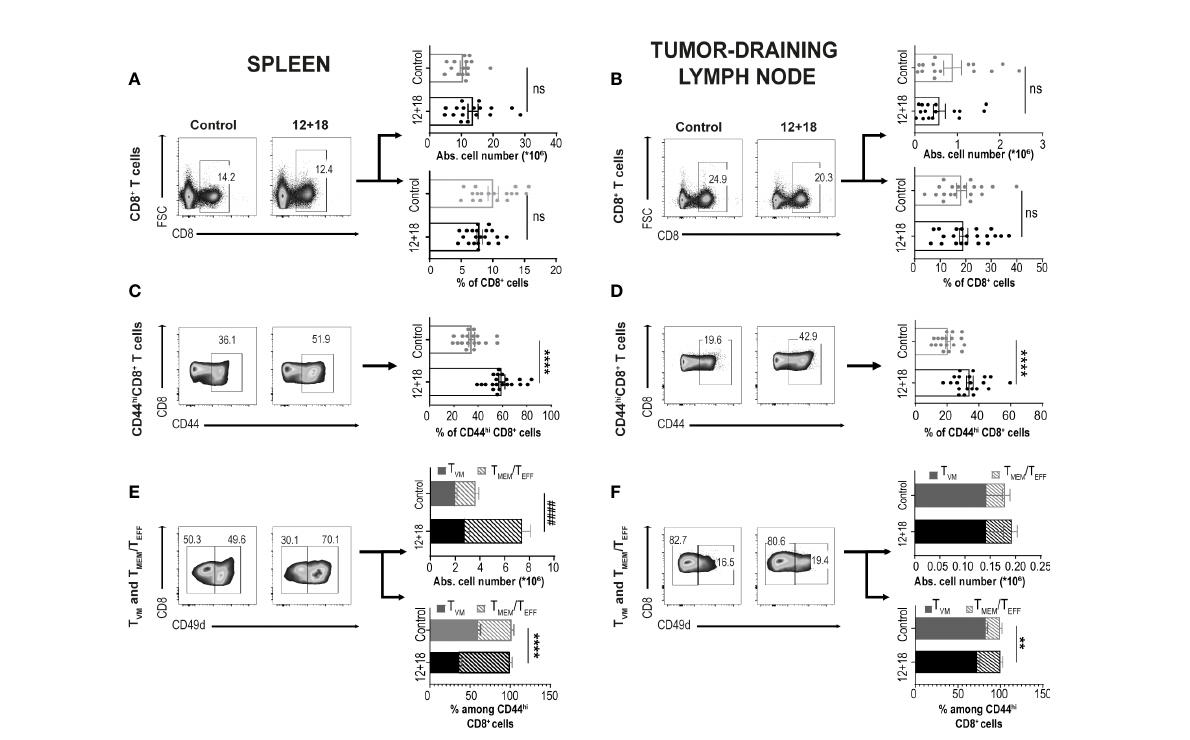
FIGURE 2 Effects of systemic co-expression of IL-12 plus IL-18 on CD8 + T lymphocytes in SLO. B16-bearing C57BL/6 WT mice were hydrodynamically injected (HI) with IL-12 plus IL-18 cDNA (12 + 18) or empty cDNA as the control. After 7 days post-HI mice were euthanized, and spleen and tumor-draining lymph nodes (dLN) were harvested and processed for fl ow cytometry. Dot plots and their respective bar graphs represent frequencies and absolute cell numbers of the speci fi ed subpopulations (Total CD8 + T cells, CD44 hi CD8 + T cells and T MEM /T EFF and T VM cells among CD44 hi CD8 + T cells) from control (left dot plots) or 12 + 18 mice (right dot plots) on (A, C, E) spleen or (B, D, F) dLN. Statistical analysis was performed with Student T test (lower B – D and lower E ), or applying Welch (A) or Mann-Whitney (upper B , upper E, F ) correction as appropriate. Values of **p<0.01, ****p<0.0001 were consider signi fi cant. #### p<0.0001 represent the statistical difference of the indicated T MEM /T EFF subpopulations. Ns, Not signi fi